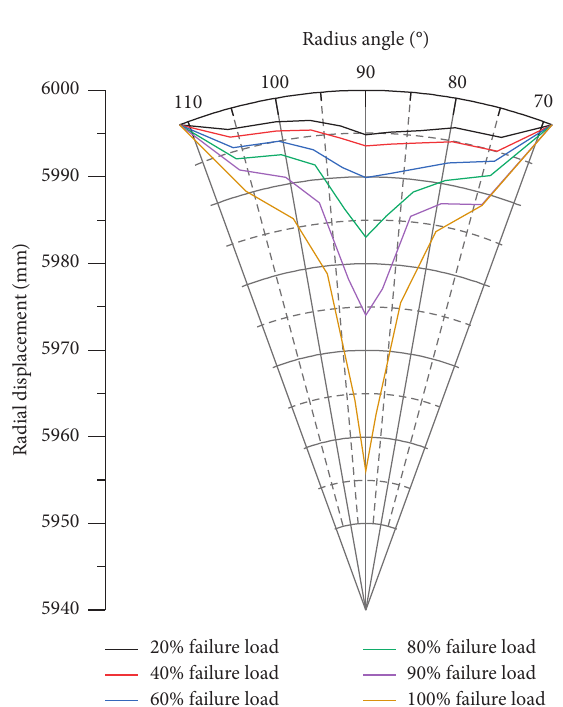
Figure 8: The overall vertical displacements for different ratios of the bending moment to the failure load of the intermediate ring of the combined